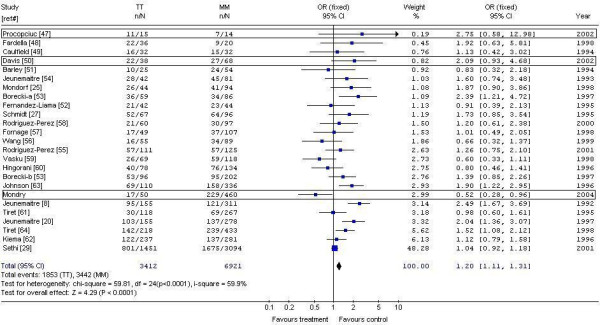
Risk of hypertension associated with the AGT M235T genotypes in Caucasians.